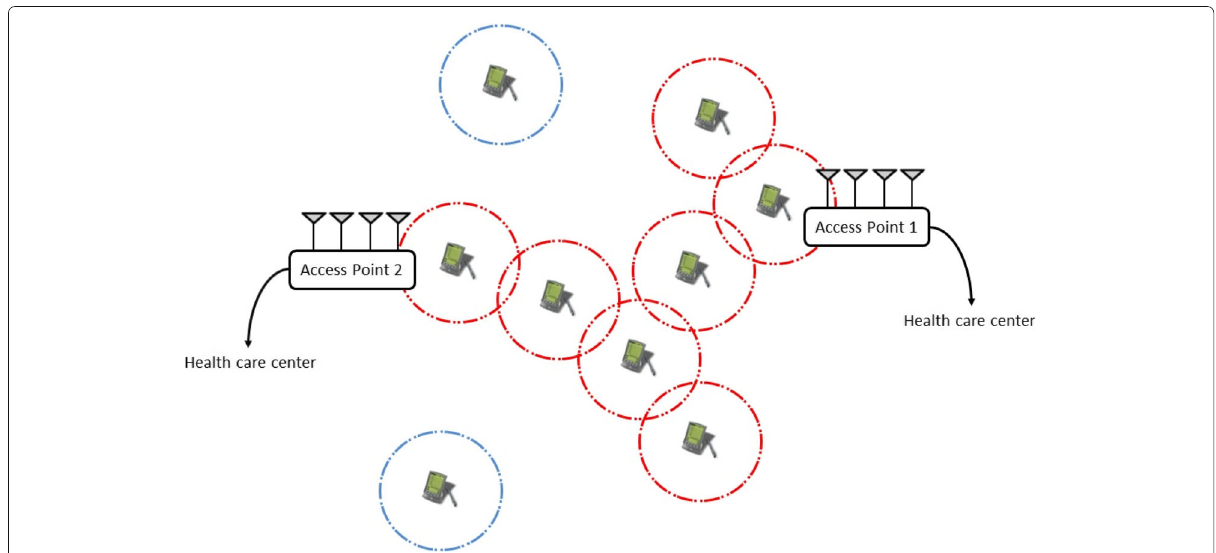
Fig. 1 Network topology of the proposed system